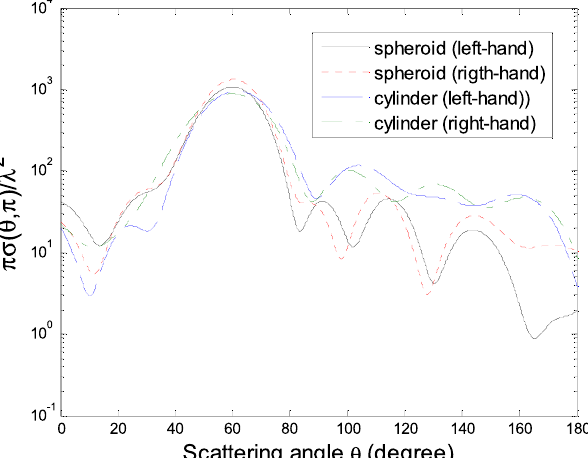
Figure 4. Normalized DSCSs πσ ( θ , π )/ λ 2 for a chiral-coated conducting spheroid (spheroid) and a chiral- coated conducting finite-length circular cylinder (cylinder) respectively as in Figs 2 and 3, but illuminated by the left-hand (left-hand) and right-hand (right-hand) CPWs ( α = 0, β = π